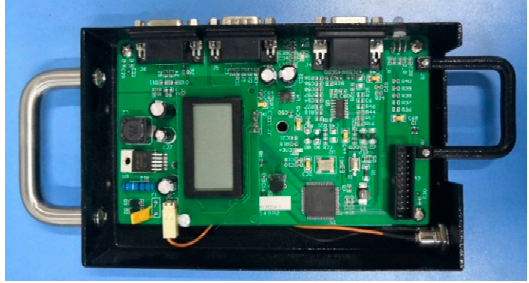
Figure 4. Photo of the device.